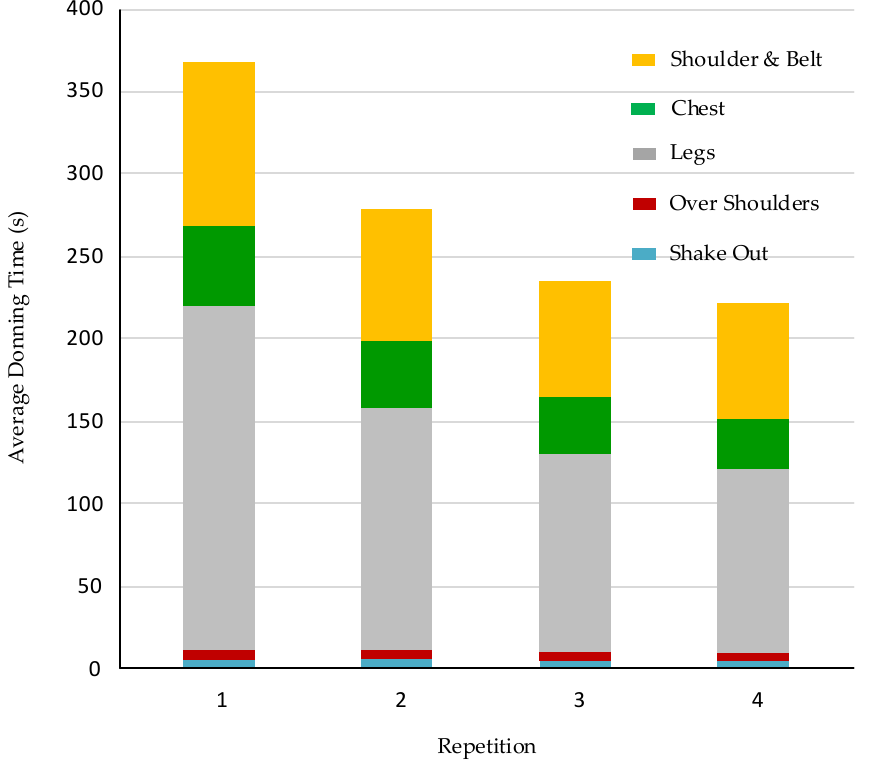
Figure 4. Mean harness donning times with step-specific contributions. Table 5. Step-specific one-way ANOVA results for the time affected by